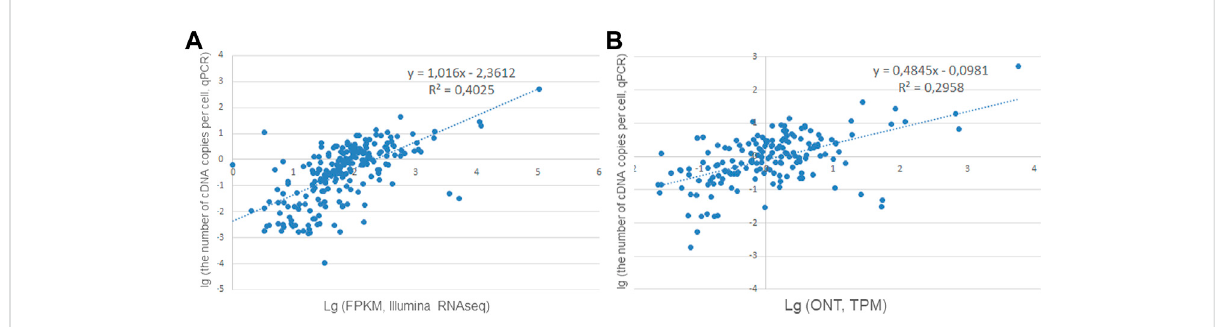
FIGURE 1 Correlation curves for converting (A) Illumina RNA-Seq data (FPKM, n = 223) and (B) ONT data (TPM, n = 171) into the number of cDNA copies per cell (PCR data).